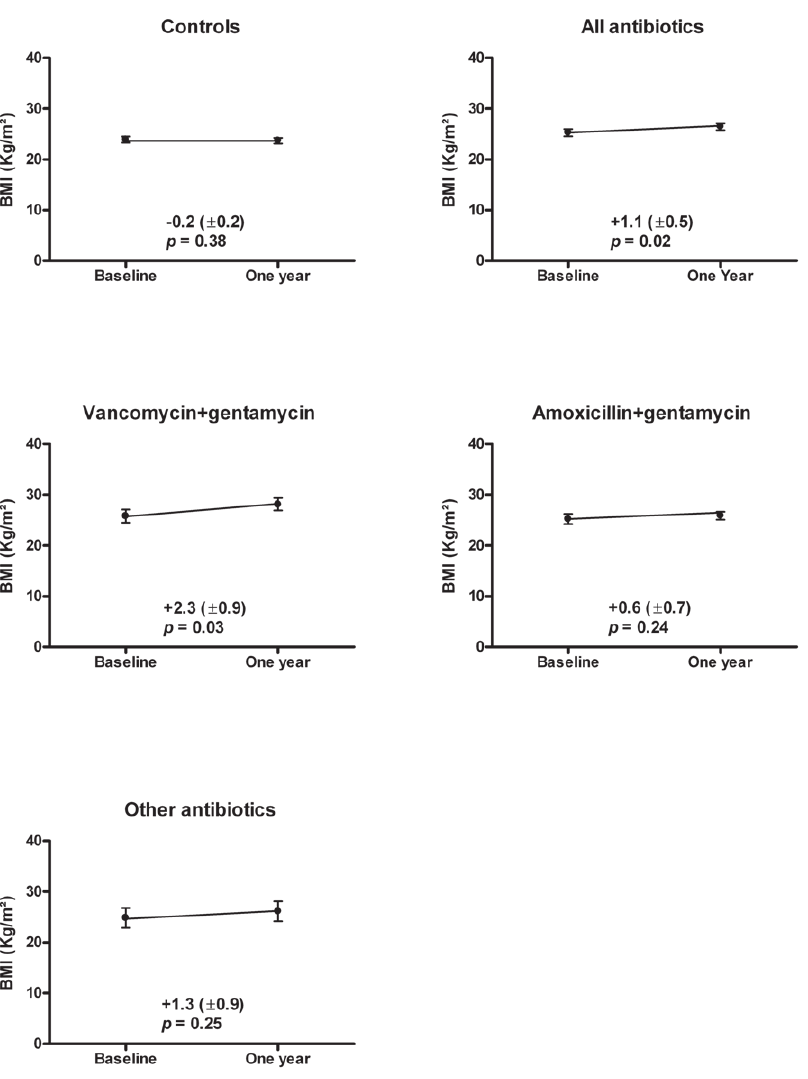
Figure 1. Body mass index (BMI) changes in controls and in patients according to their antibiotic treatment.